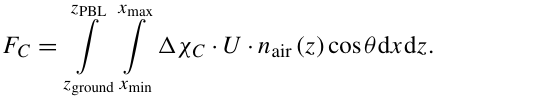
and 0 . 055 ◦ × 0 . 055 ◦ for the UK model domain. The vertical column was divided into 21 layers from the surface (bottom layer ∼ 50 m) up to 100 hPa ( ∼ 16 km) in sigma